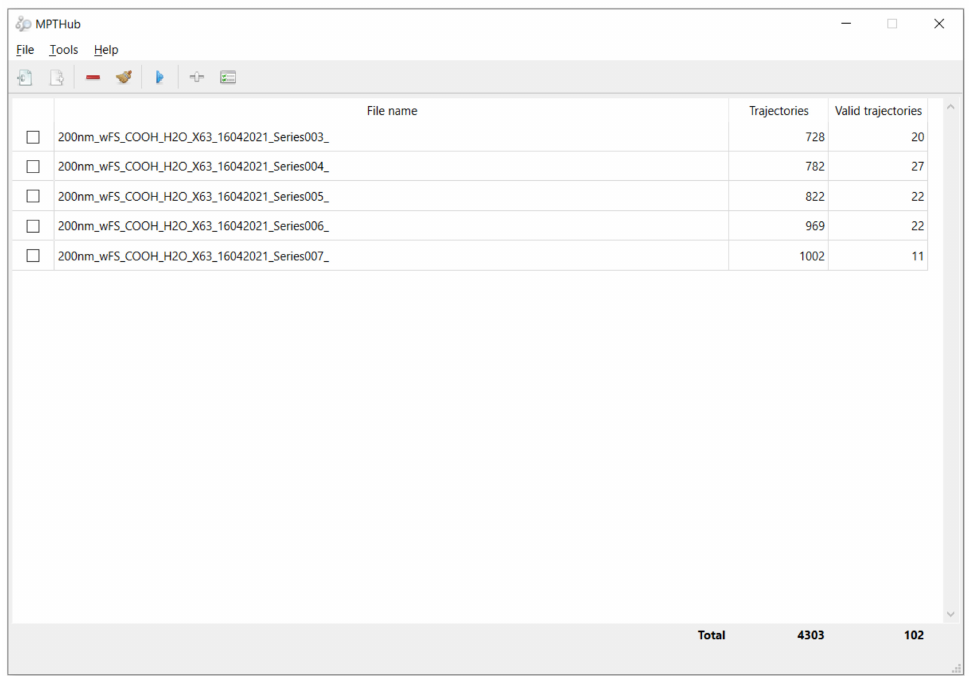
Figure 2. Launch screen capture of MPTHub. Multiple input files are presented (file names, total trajectories, and valid trajectories according to defined settings). Included icons are used under a CC BY 3.0 license (Copyright 2021, Yusuke Kamiyamane, available at https://p.yusukekamiyamane. com/; accessed on 15 September